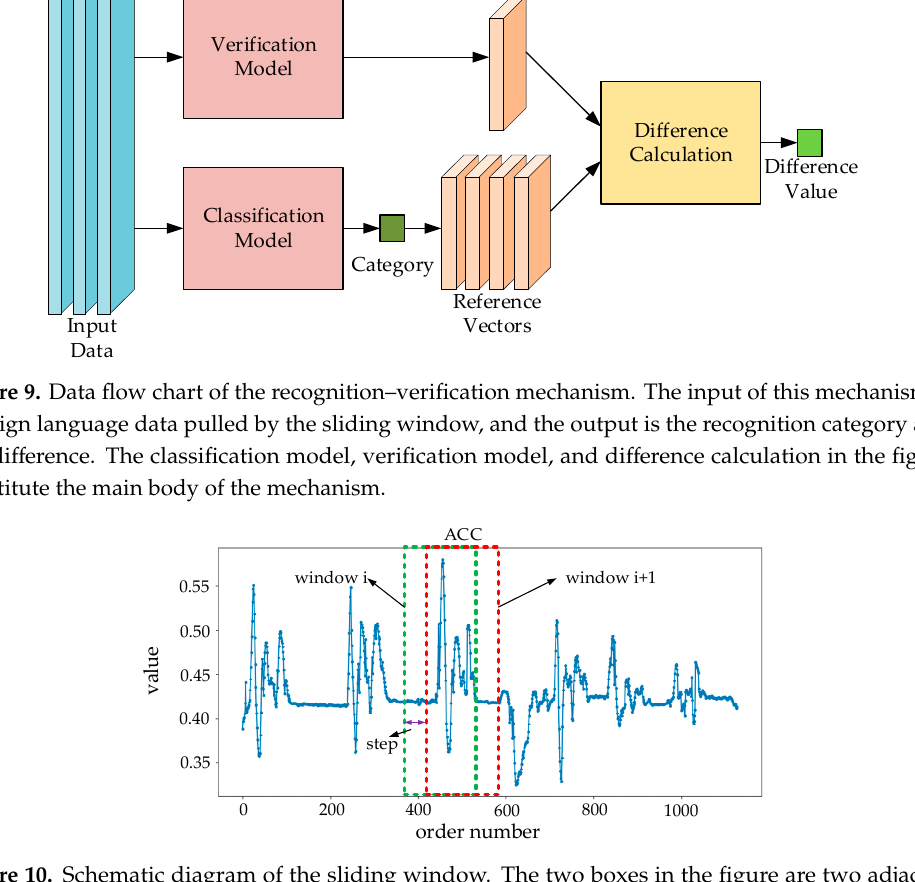
Figure 10. Schematic diagram of the sliding window. The two boxes in the figure are two adjacent positions during the moving process of the sliding window, the green window is the first position, and the red window is the last one during the moving process.